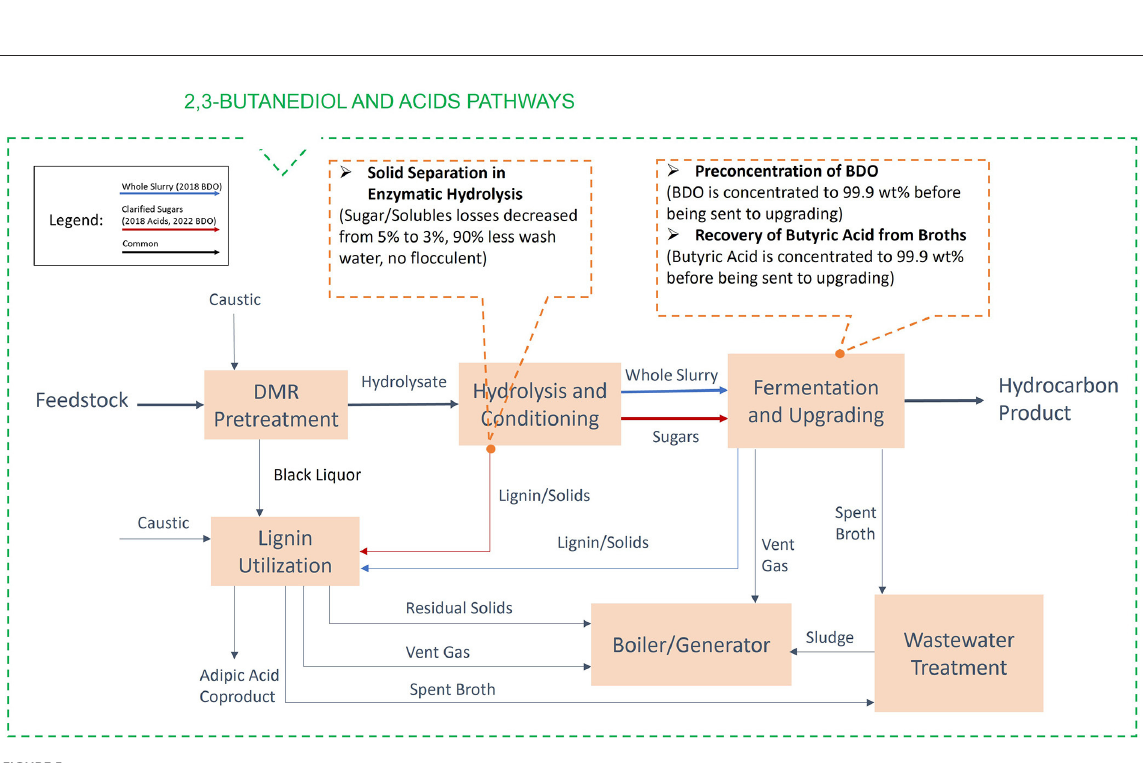
FIGURE5 Process diagram for the biochemical process through the 2,3-butanediol and acids pathways, with the locations of the assessed separation challenge